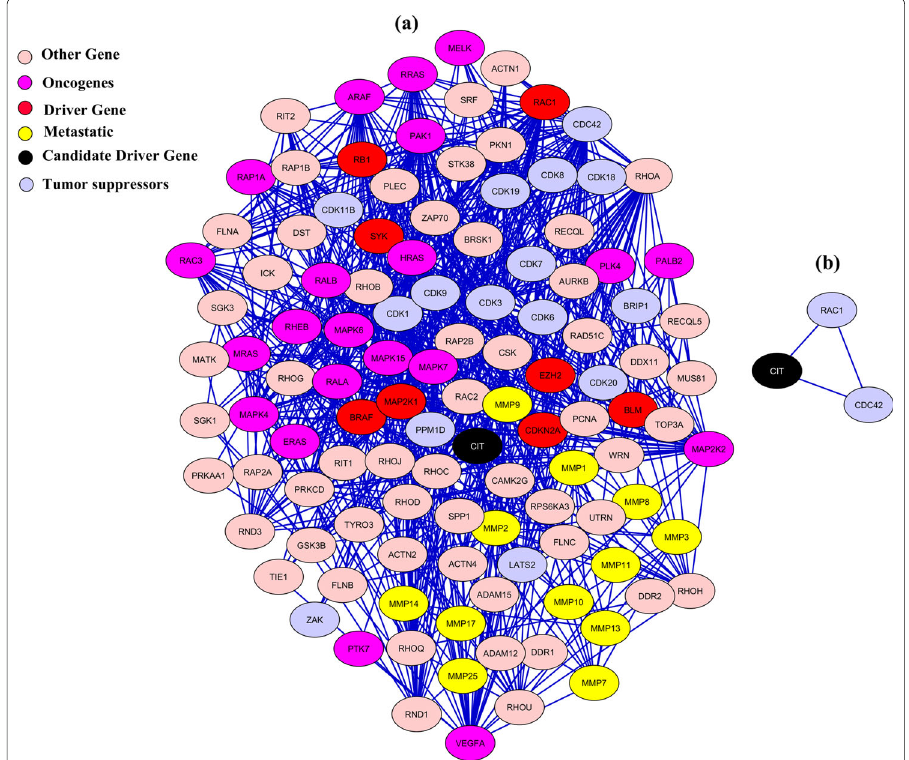
Fig. 4 Melanoma Network. The STRING graph for invasive subtype of melanoma based on the genes archived by our